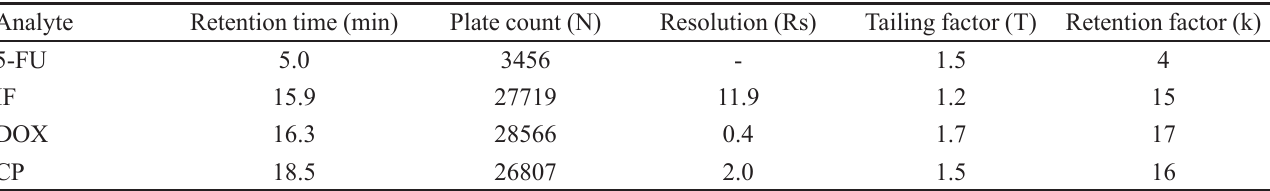
TABLE I - System suitability parameters* for HPLC-UV method evaluated for simultaneous determination of fluorouracil, ifosfamide, cyclophosphamide and